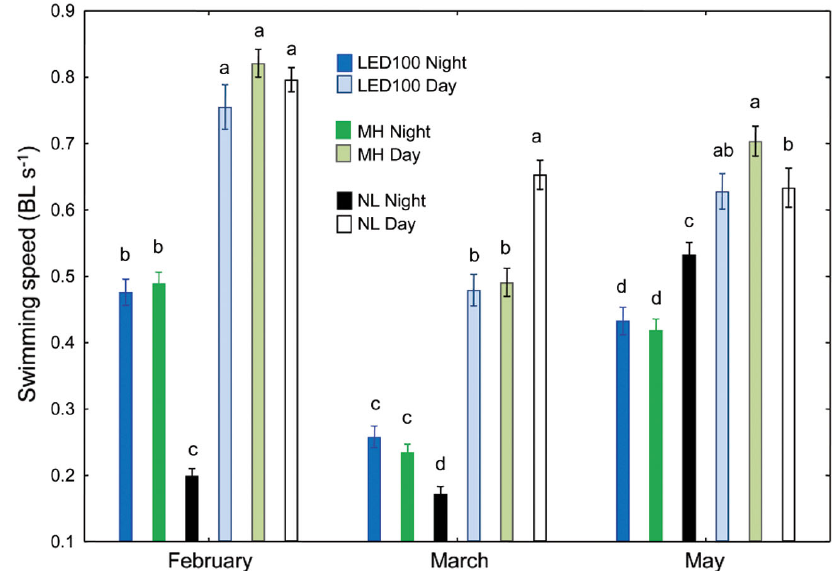
Fig. 7. Nighttime and daytime aver- age swimming speed (body lengths [BL] s −1 ) of Atlantic salmon Salmo salar in the natural light (NL), metal halide (MH) and maximum-output LED (LED100) groups in February, March and